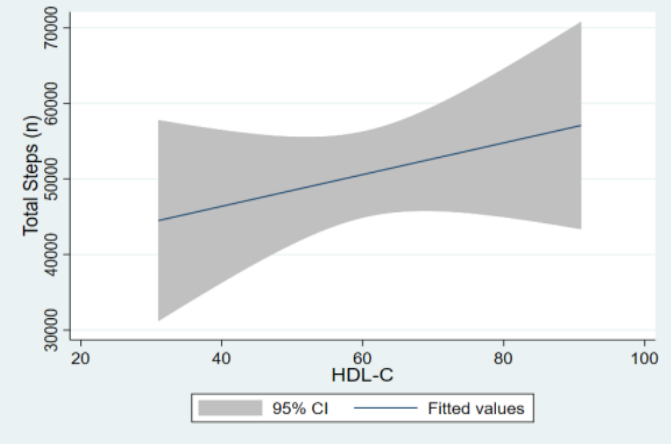
Figure 1. Association of the amount of physical exercise with the patients’ HDL levels in patients with non-vigorous exercise.